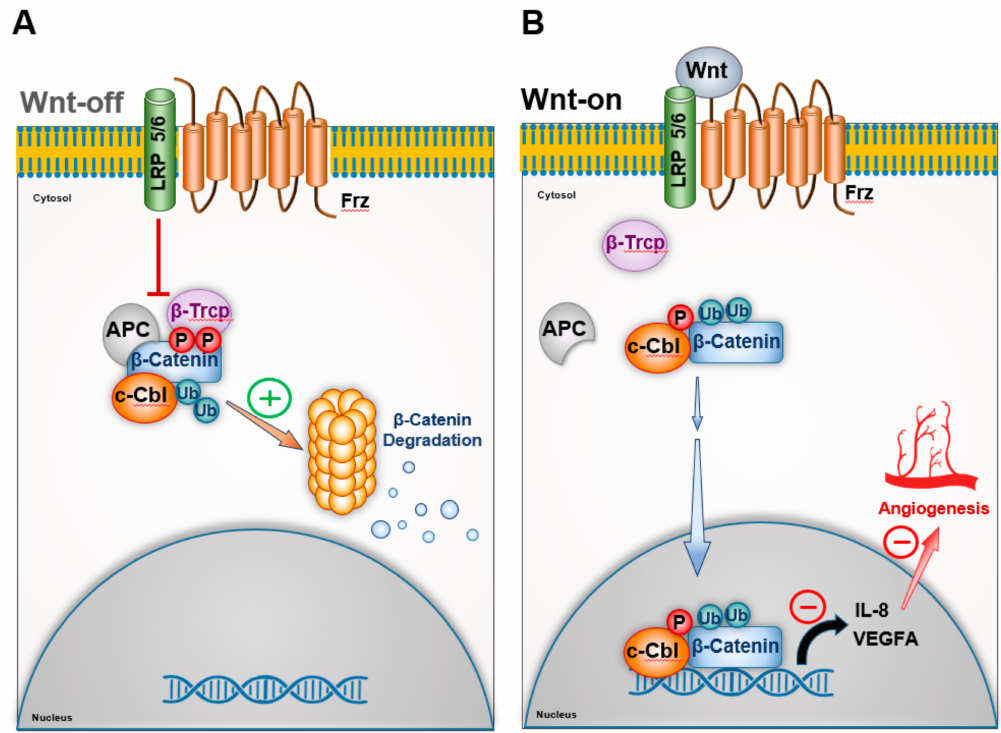
Figure 2. c-Cbl regulates angiogenesis through Wnt signaling. Constitutively Wnt signaling is suppressed in endothelial cells. In absence of Wnt ligand, β -Catenin is downregulated by in a destruction complex in the cytosol consisting of Adenomatous Polyposis Coli (APC), where β -Catenin gets phosphorylated by GSK3 β . This results in β -catenin ubiquitination and proteasomal degradation by E3 ligases such as c-Cbl and β -TrCP, etc. Wnt ligand activates Frz receptors, which dissociates the destruction complex, β -catenin undergoes nuclear translocation and activates the Wnt target genes such as IL-8 and VEGF-A to induce angiogenesis. Wnt activation results in phosphorylation of c-Cbl, its nuclear translocation, wherein it ubiquitinates nuclear β -catenin to switch-o ff the Wnt signaling and